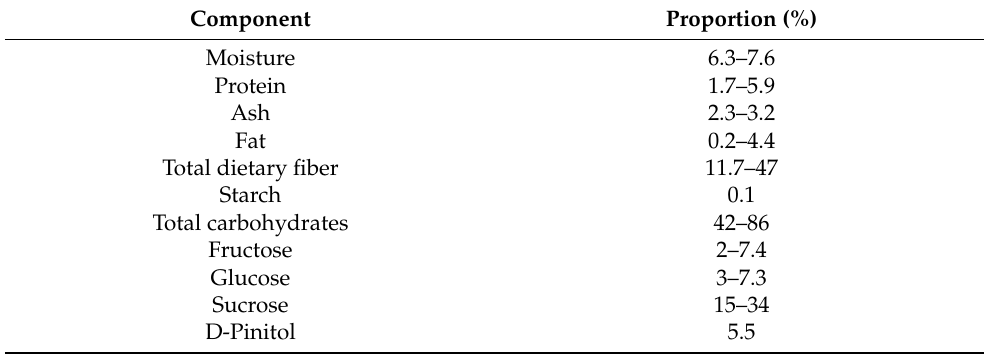
Table 1. General composition of Carob fruits